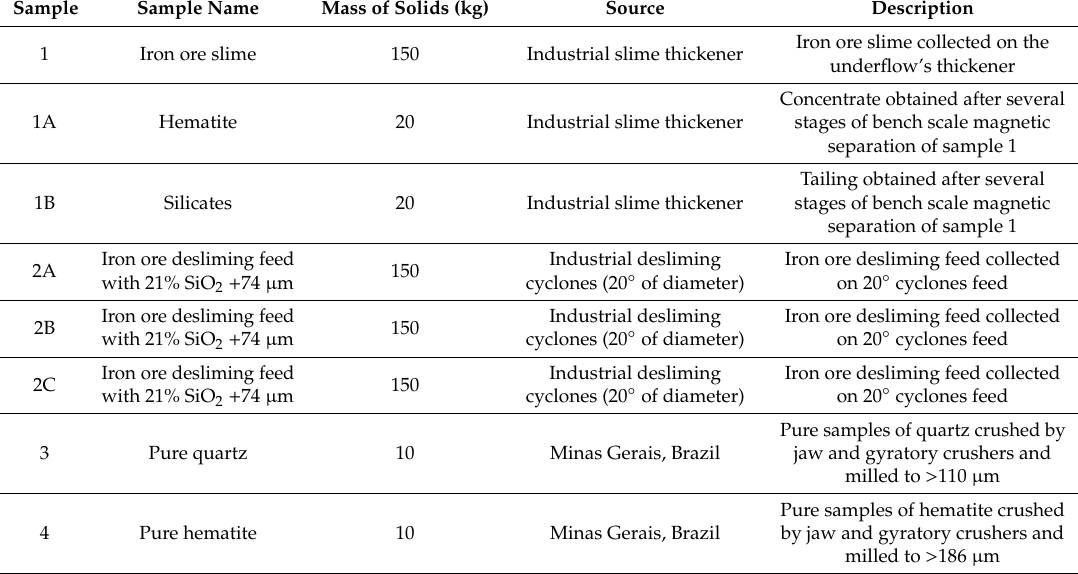
Table 3. General characteristics of the